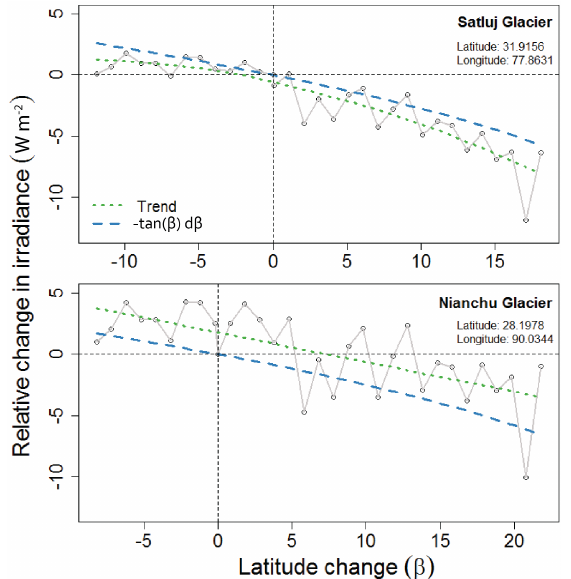
Figure 7. Idealized scenarios for Satluj and Nianchu glaciers. Rela- tive change in mean irradiance due to topographic shading as glacier is moved up and down in latitude, both spanning latitude from 20 to 50 ◦ . Mean values are connected (grey) to show stochasticity. The overall trend (green dotted line) shows that the effects of shading in- crease with increasing latitude ( β ). The relative change mirrors the function − tan (β) d β (blue dashed), which underestimates the rel- ative change for Satluj Glacier and overestimates that for Nianchu Glacier.